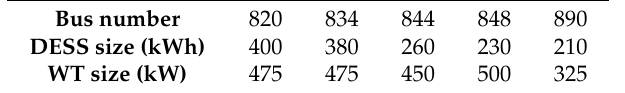
Table 4. System optimization results from the MG perspective without controllable load.